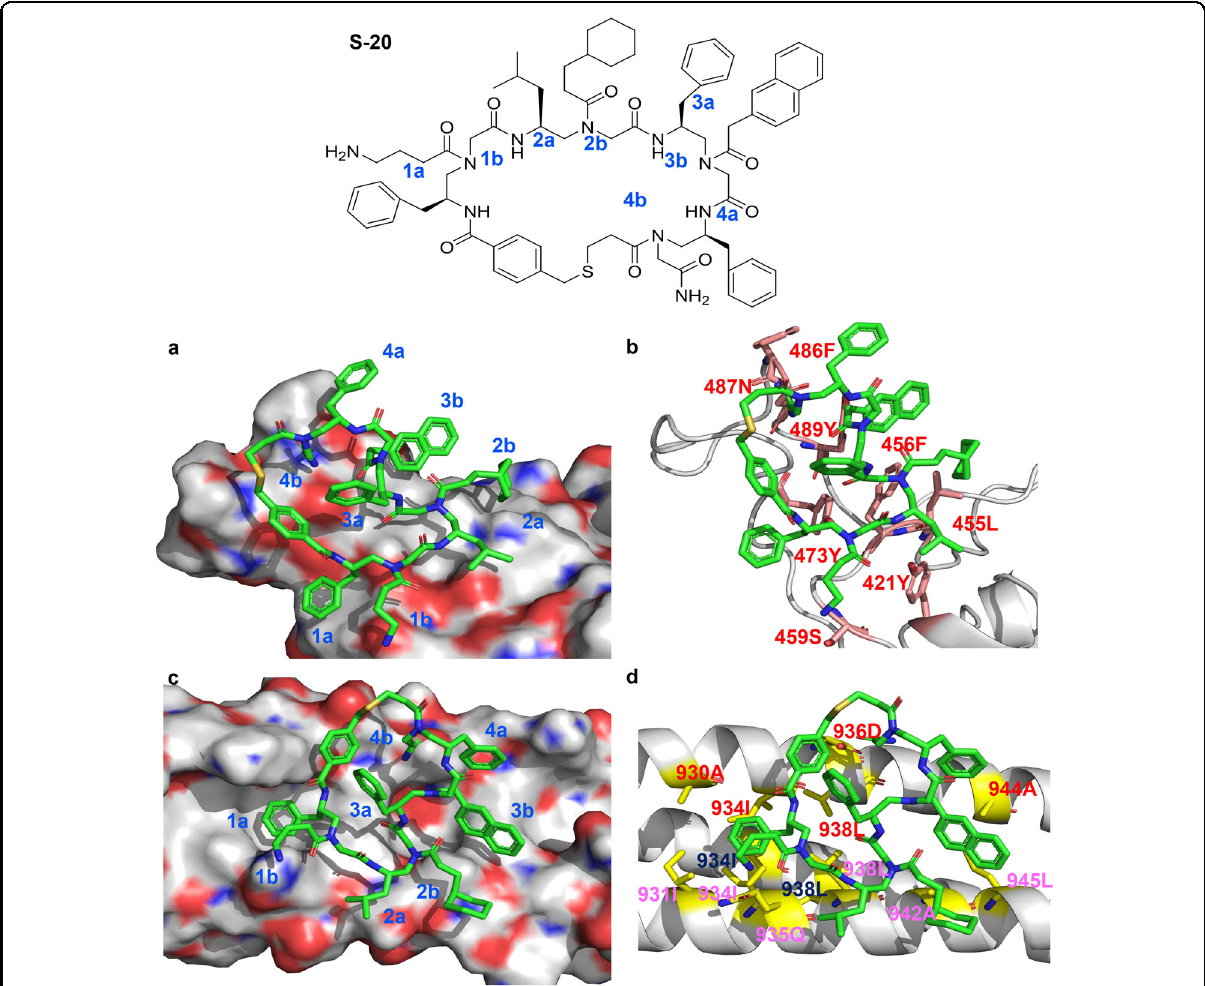
Fig. 7 The chemical structure of S-20 and molecular docking analysis of the interaction between S-20 and its potential target sites. Side chains of S-20 are designated by a (chiral side chain) or b (acyl side chain) in each AApeptide building block, respectively. Residues of HR1 from different helical chains are shown in red, black, and purple,